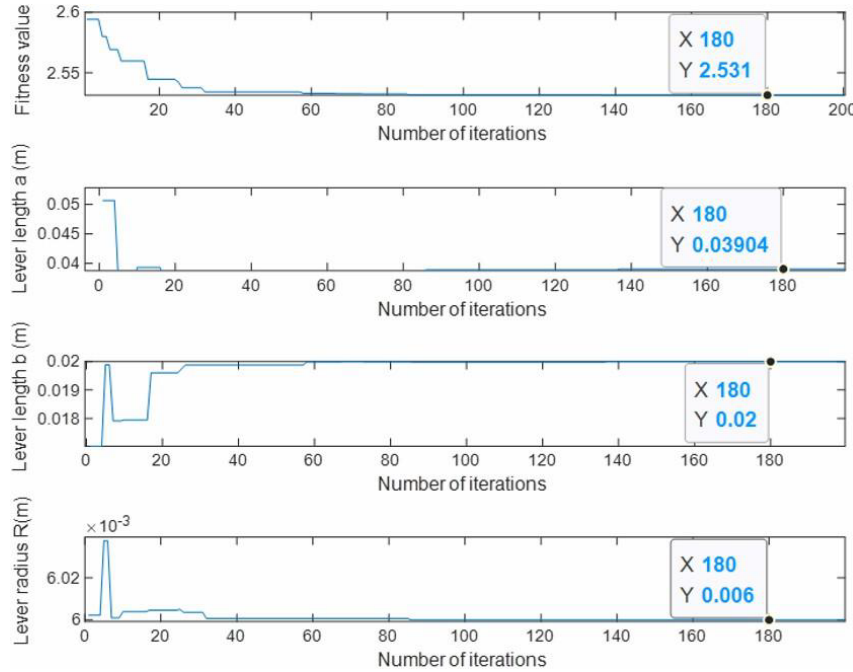
Figure 8. Genetic algorithm simulation results.